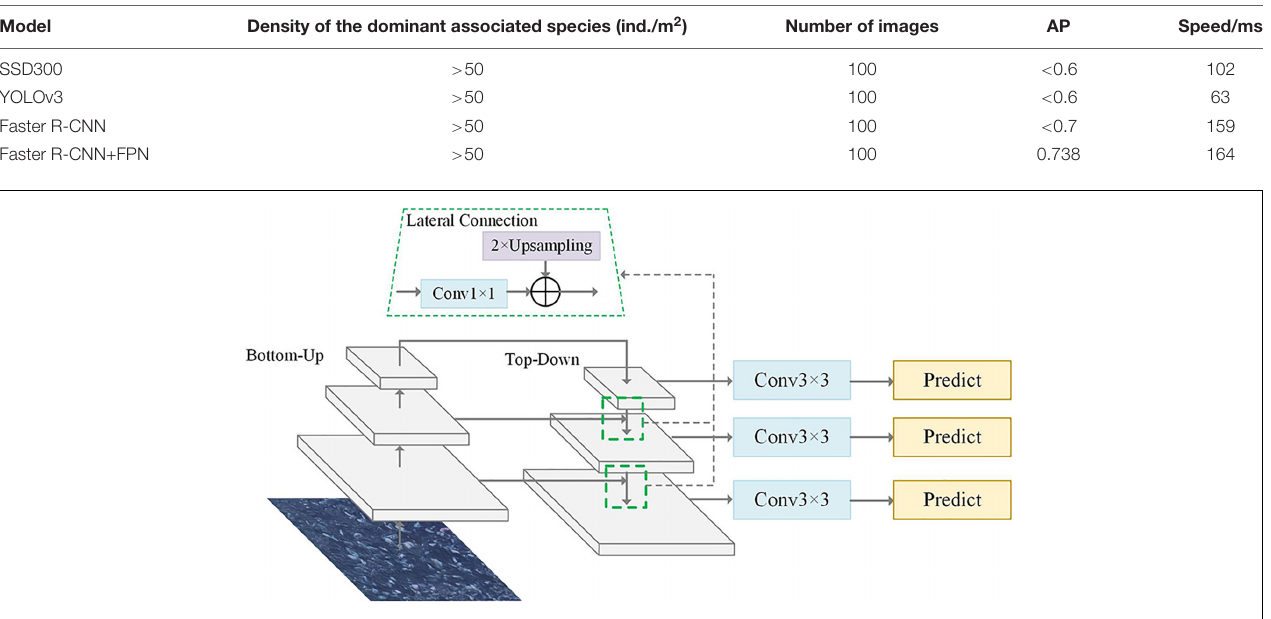
TABLE 2 | The comparison of different models.